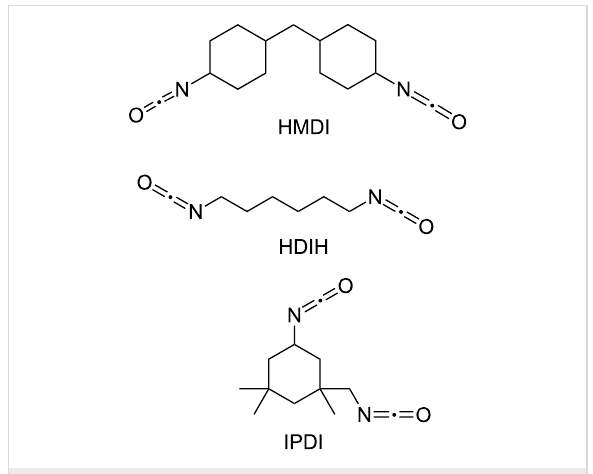
Figure 2: Aliphatic diisocyantes HMDI, HDI,